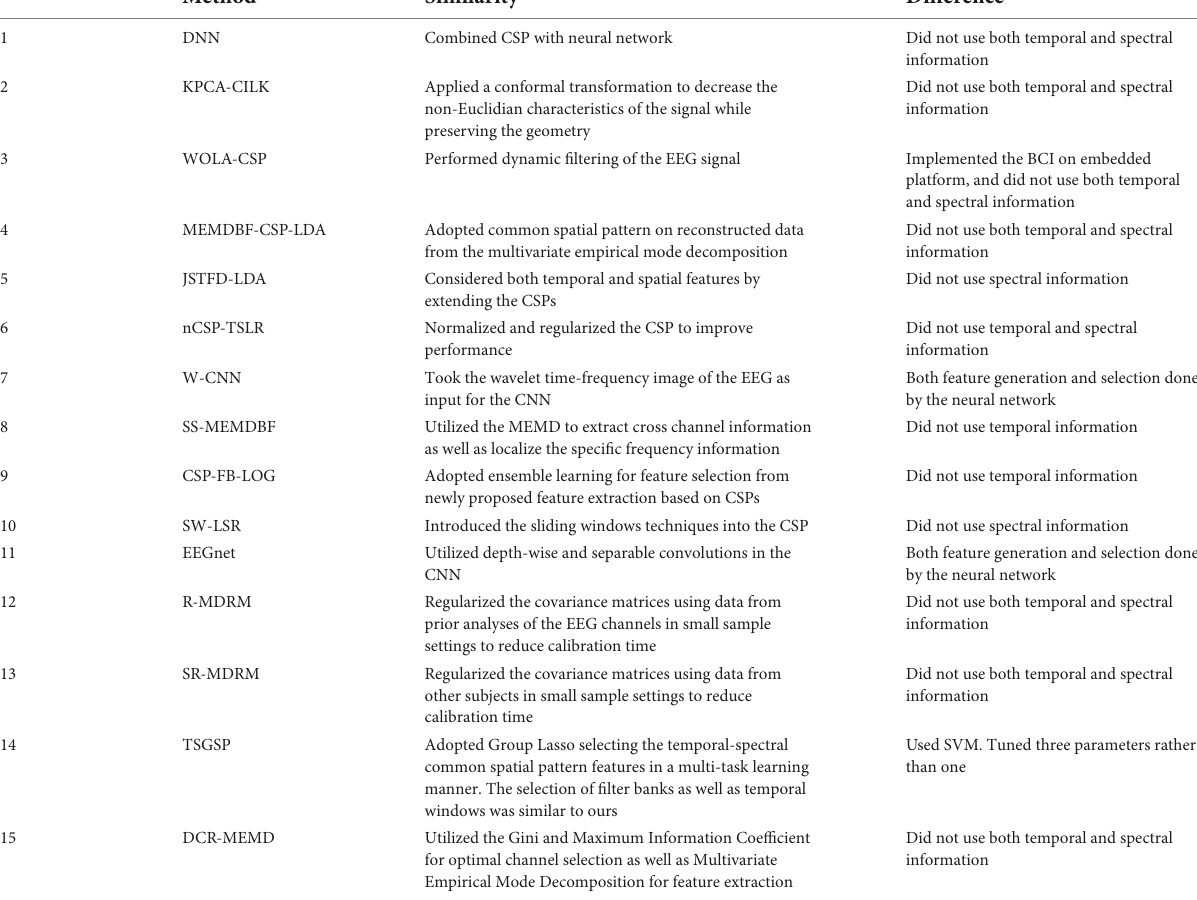
TABLE 10 Comparison of contender algorithm implemented with dataset